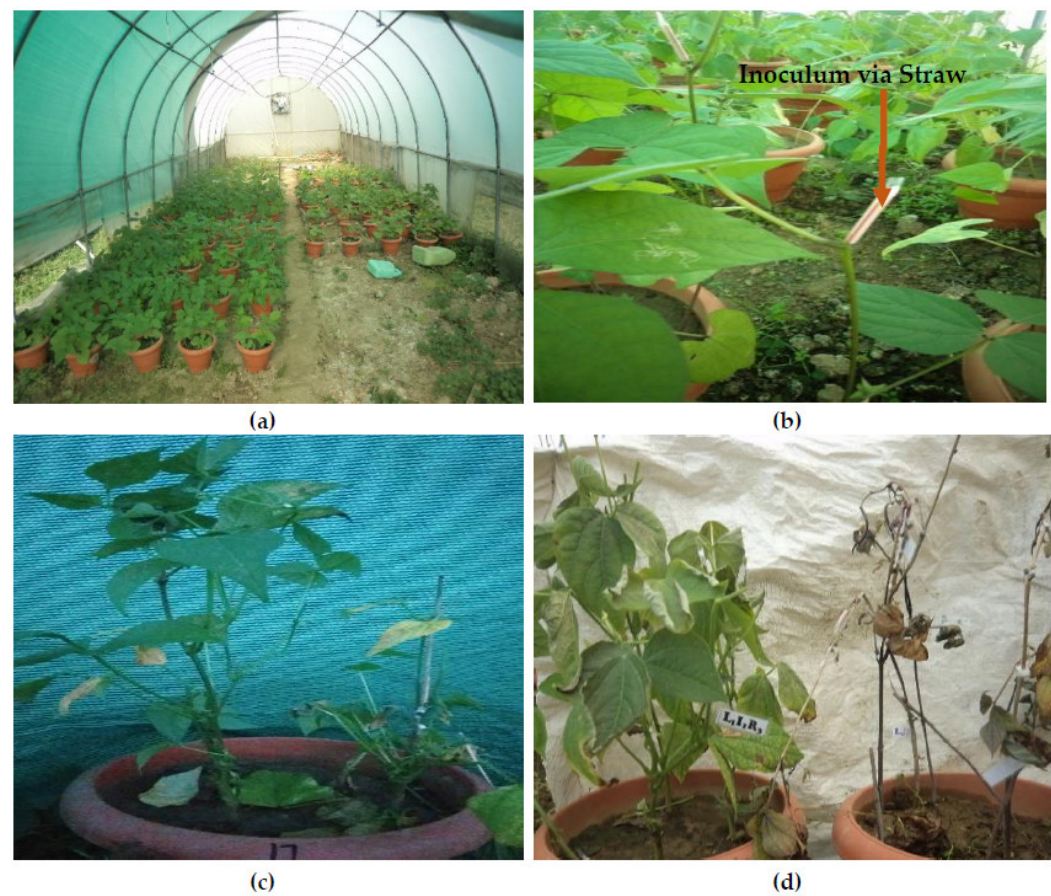
Figure 7. Germplasm screening under controlled conditions against most virulent isolate of mold pathogen: ( a ) General view of bean germplasm before inoculation; ( b ) Inoculated plants; ( c ) Control vs. inoculated plants 15 DAI; ( d ) Resistant line WB-1402 vs. Susceptible line. Table 7. Screening results of bean genotypes against the most virulent isolate.